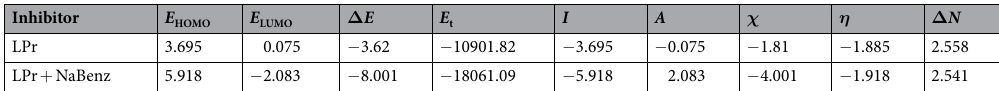
Inhibitor E HOMO